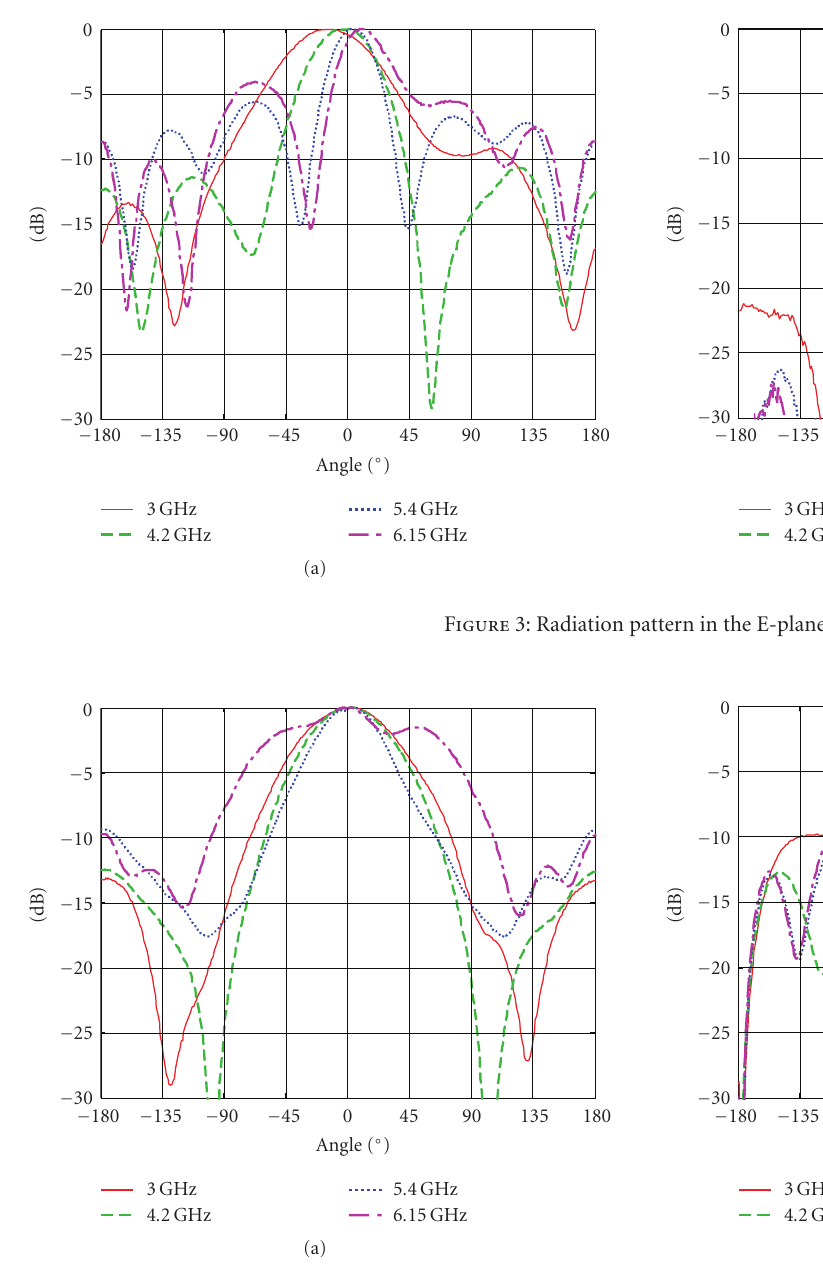
Figure 4: Radiation pattern in the